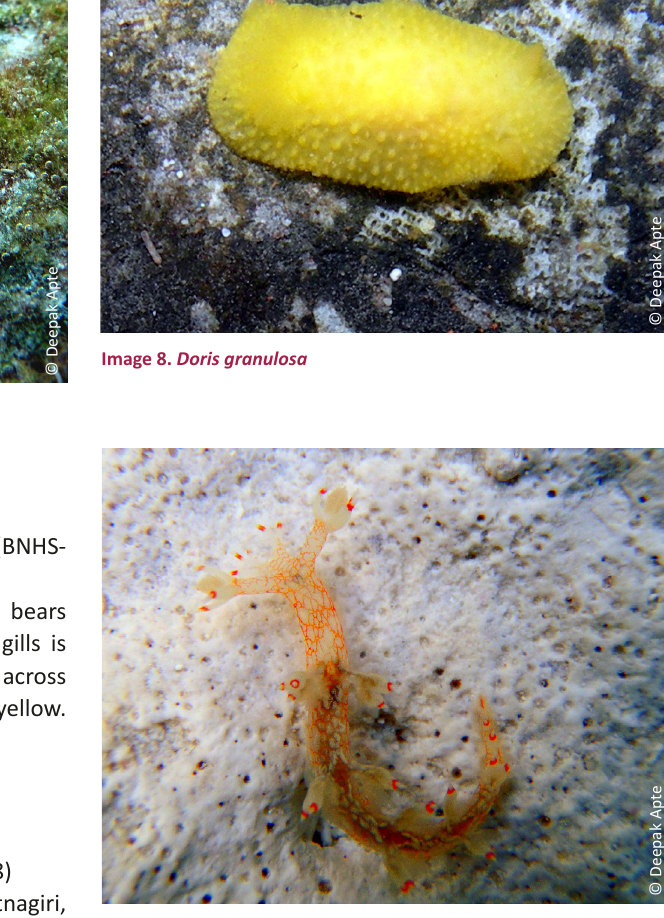
Image 9. Bornella stellifer